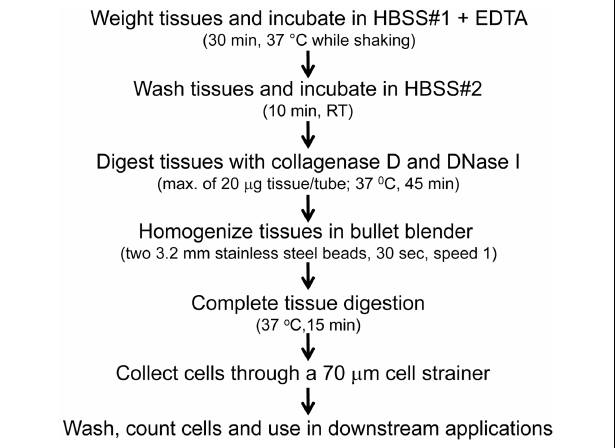
FIGURE 1 | Methodological diagram for the isolation of gastric LPMC . A detailed description of the optimized procedure for isolation of LPMC is found in the Section “Materials and